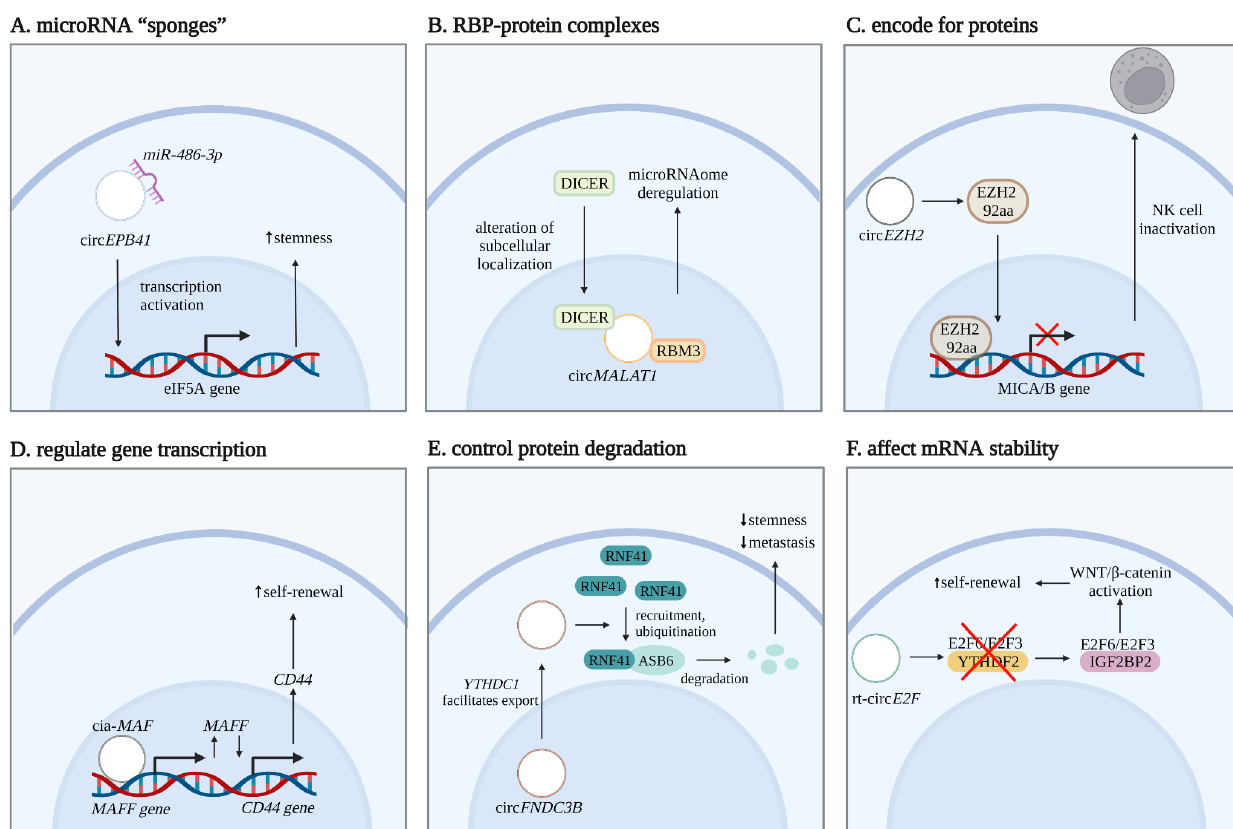
Figure 5. The mechanisms of action of circRNAs in cancer stem-like cells (based on recent reports). Circ EBP41 acts as a sponge for miR-486-3p , effectively inducing the expression of eIF5A ( miR-486-3p target) to maintain cell stemness ( A ). Circ MALAT1 creates a nuclear RNA/protein complex with DICER and RBM3 proteins, thus, affecting the cell’s microRNAome composition ( B ). Circ EZH2 en- codes for EZH2-92aa peptide that inhibits NK cell activity ( C ). Cia-MAF (circRNA activating MAFF) binds to the MAFF promoter and enhances MAFF expression, which induces CD44 transcription, promoting stem cell traits ( D ). circ FNDC3B inhibits stemness and metastasis via RNF41-dependent ASB6 degradation ( E ). Rt-circ E2F promotes the association of E2F6/E2F3 mRNAs with N-methyl- adenosine (m6A) reader IGF2BP2 and inhibits their association with another m6A reader, YTHDF2, thus promoting self-renewal of cancer stem-like cells ( F ).